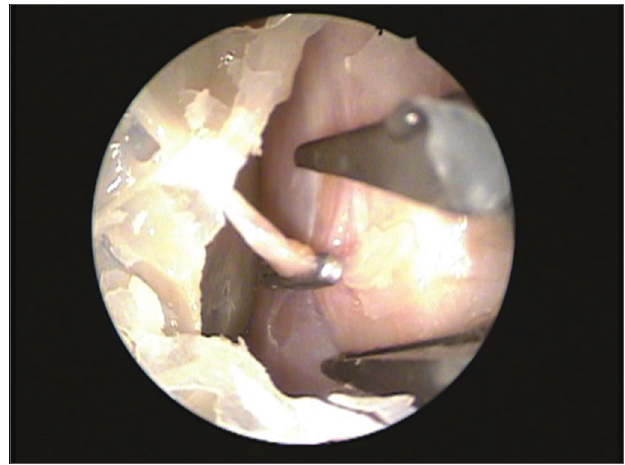
Figura 4. Ligclip em artéria etmoidal anterior esquerda, em plano subperiosteal.